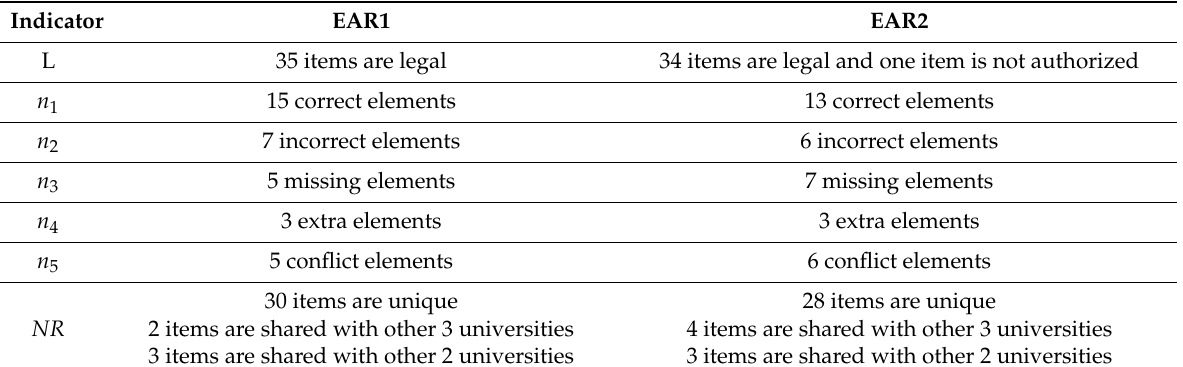
Table 1. Description of two academic records in a university node.